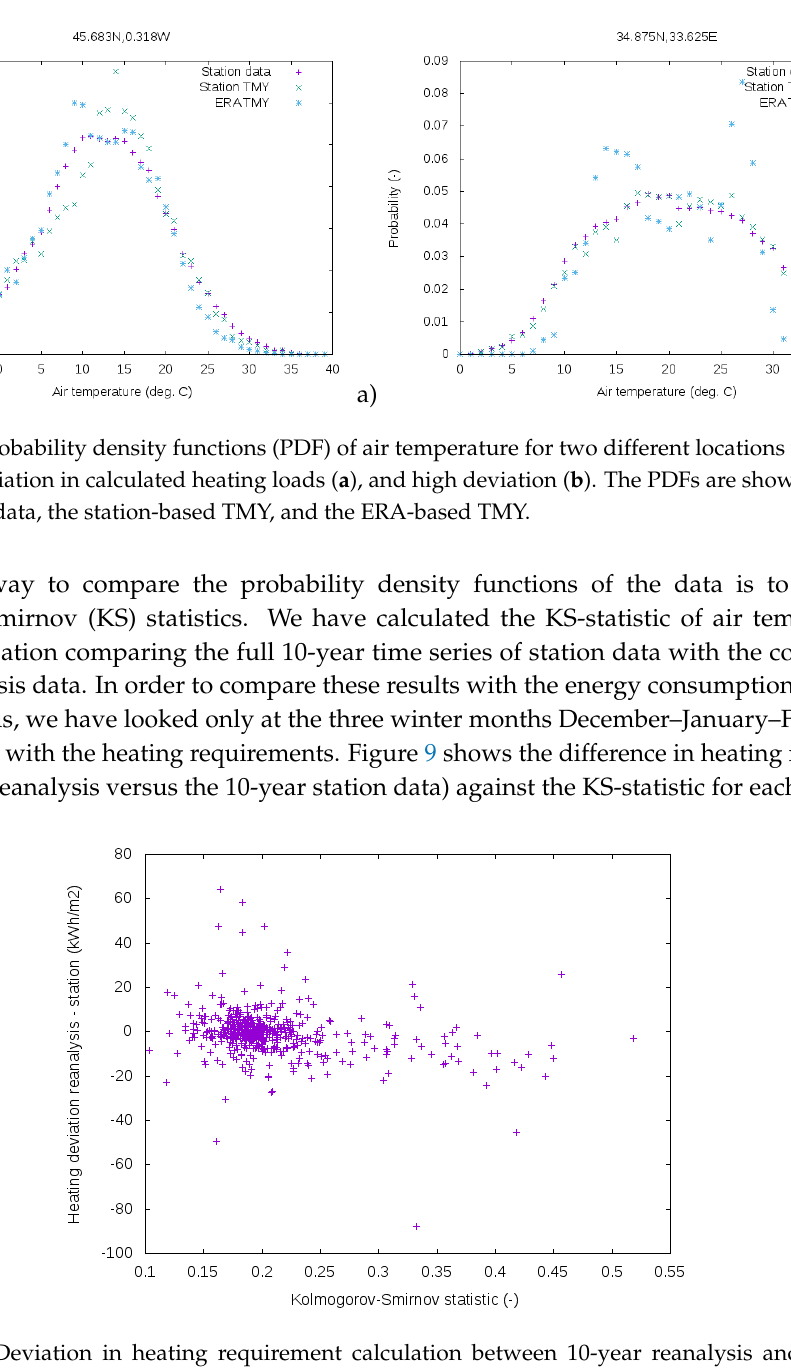
Figure 9. Deviation in heating requirement calculation between 10-year reanalysis and station data, plotted against the Kolmogorov–Smirnov statistic for air temperature using the winter months (December–January–February) of the 10-year reanalysis and station